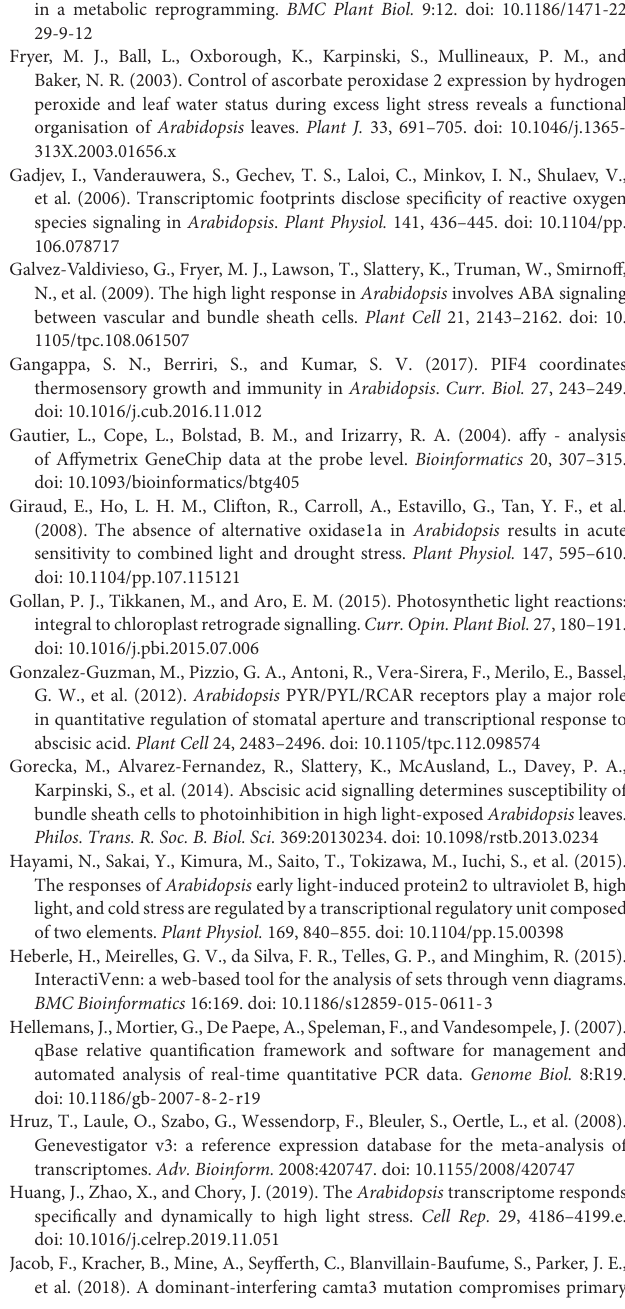
Supplementary Figure 1 | Genes co-expressed with APX2 , ELIP2 , and ZAT12 were identified with the Arabidopsis Coexpression Tool and displayed in a cladogram (Zogopoulos et al., 2021). Supplementary Figure 2 | Relative expression scaled to the Col-0 control (set to 1), after 1 h HL (growth condition Turku, Table 1 ) or 1 h O 3 (350 nL L − 1 , growth condition Helsinki-1) in Col-0 and pyr/pyl112458 . The average of three biological replicates are shown; error bars depict standard deviation. Two-way ANOVA with Tukey’s test was used for statistical analysis and depicts significant differences compared to Col-0 control ( ∗ P < 0.05; ∗∗ P < 0.01;